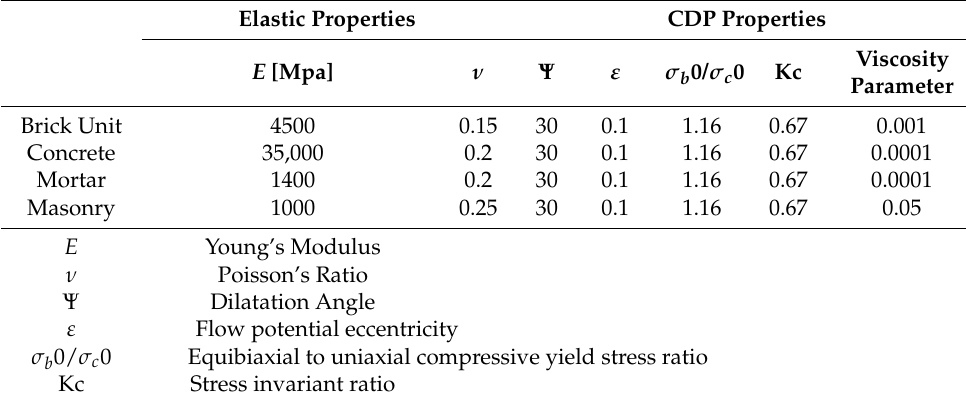
Table 1. Material properties of brick units, concrete, mortar and masonry.